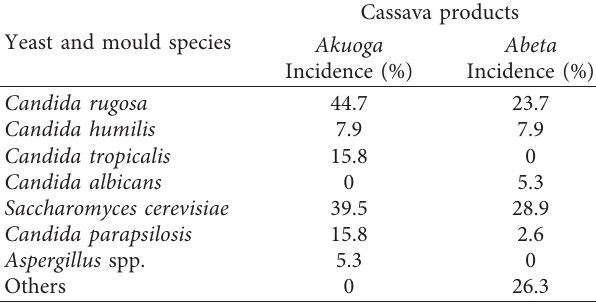
Table 3: Incidence of yeast and mould in the cassava products.